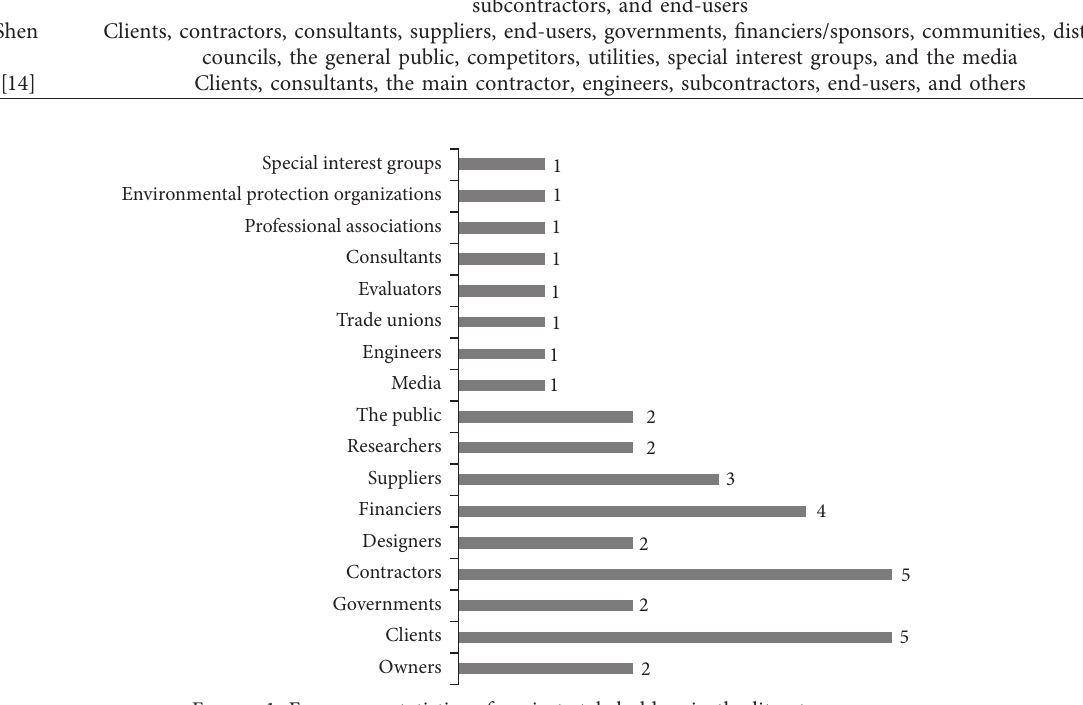
Figure 1: Frequency statistics of project stakeholders in the